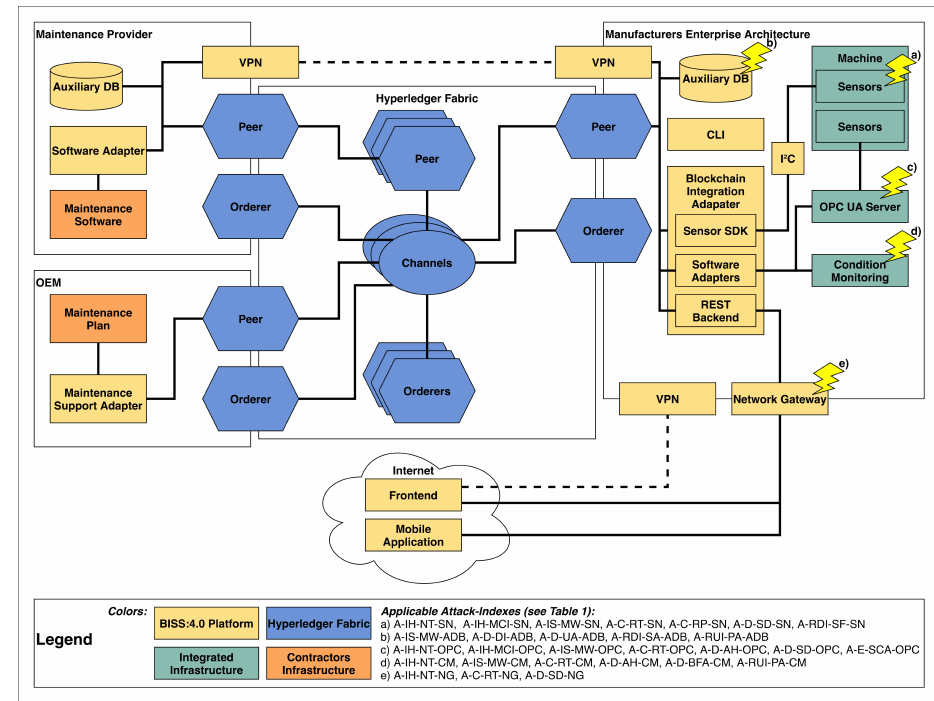
Figure 1. The BISS:4.0 platform with selected attacks (Indexes are taken from Table